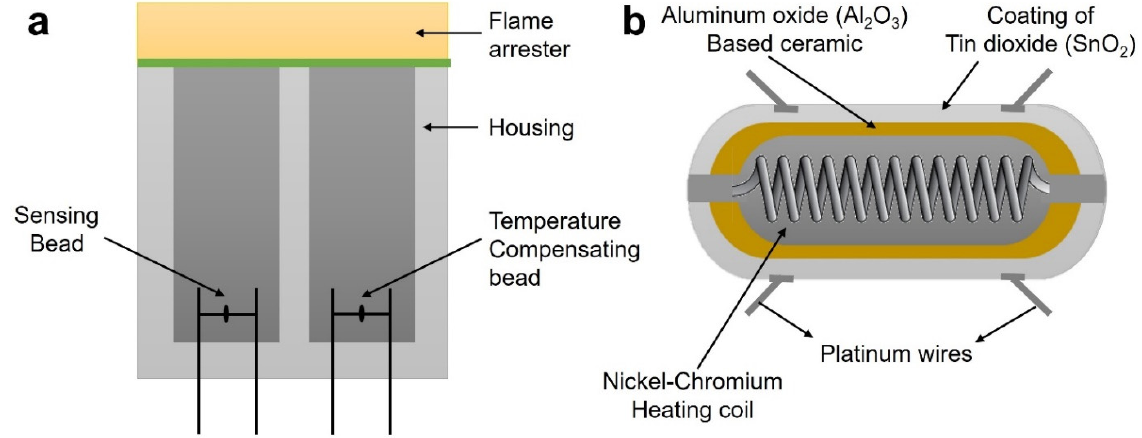
Figure 7. Gas sensors: ( a ) catalytic beads combustible gas sensor; ( b ) metal oxide semiconductor (MOS)-based resistive sensor.